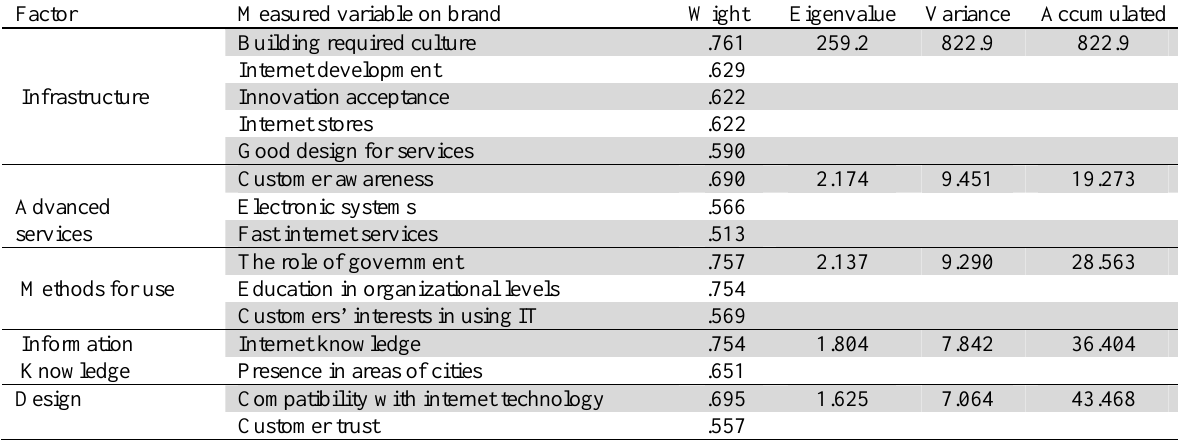
The summary of factor